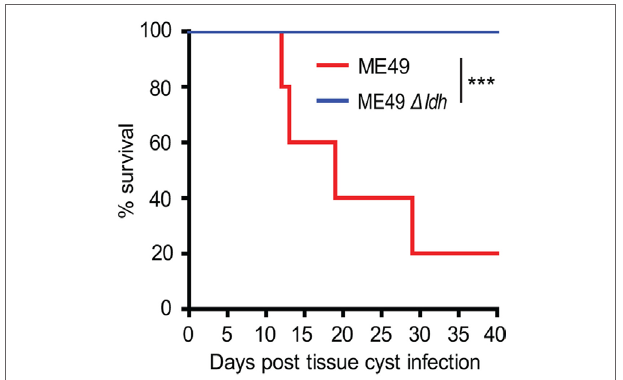
FigUre 1 | Virulence tests of Toxoplasma cysts in mice. ICR mice were infected with brain cysts of ME49 or ME49 Δ ldh (50 cysts/mouse, n = 5 mice for ME49 strain and n = 7 mice for ME49 Δ ldh strain) by oral administration and their survival was monitored for 40 days. *** p < 0.001, Gehan–Breslow– Wilcoxon